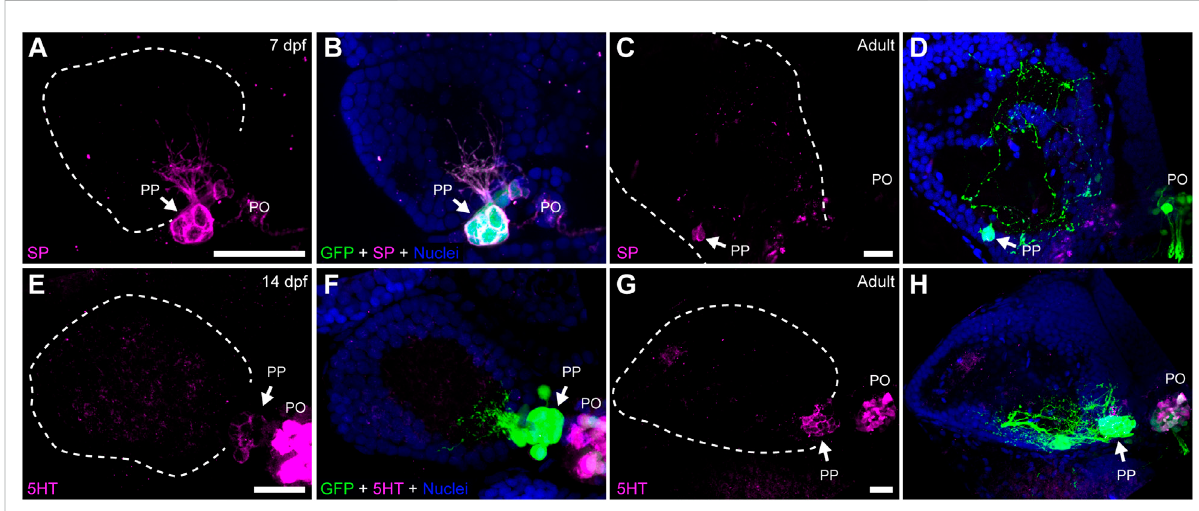
FIGURE 3 ParapinealcellsshowimmunoreactivityagainstsubstancePandserotoninduringontogeny.Indirectimmuno fl uorescenceagainstsubstanceP (SP) (A – D) andserotonin(5HT) (E – H) inlarval(7and14 dpf)andadult(1.5 – 2 yearold)Tg( foxd3::GFP )zebra fi sh.Imagescorrespondtodorsalviewsof confocalz-stackmaximumprojections,withanteriortothetopandlefttotheleft,showingthe fl uorescencesignalcorrespondingtoSP(magentain (A,C) ) and 5HT (magenta in (E,G) ), or the merge fl uorescence signals that also include the GFP of the pineal complex (green) and the DAPI/ Hoechst nuclear staining providing the left habenula tissue context (blue) (B,D,F,H) . Arrows indicate parapineal neurons immunoreactive to SP and 5HT. Abbreviations: PO (pineal organ at the level of the stalk), PP (parapineal). Samples: 7 dpf SP ( n = 5), adult SP ( n = 5), 14dpf 5HT ( n = 5), adult 5HT ( n = 5). Scale bars, 10